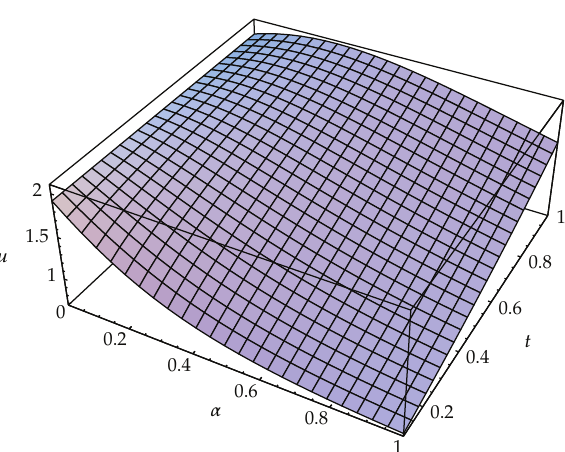
Figure 3: The surface of second-order approximate solution of (cid:2) 3.12 (cid:3) when x (cid:9) 0 . 8, β (cid:9) 1.